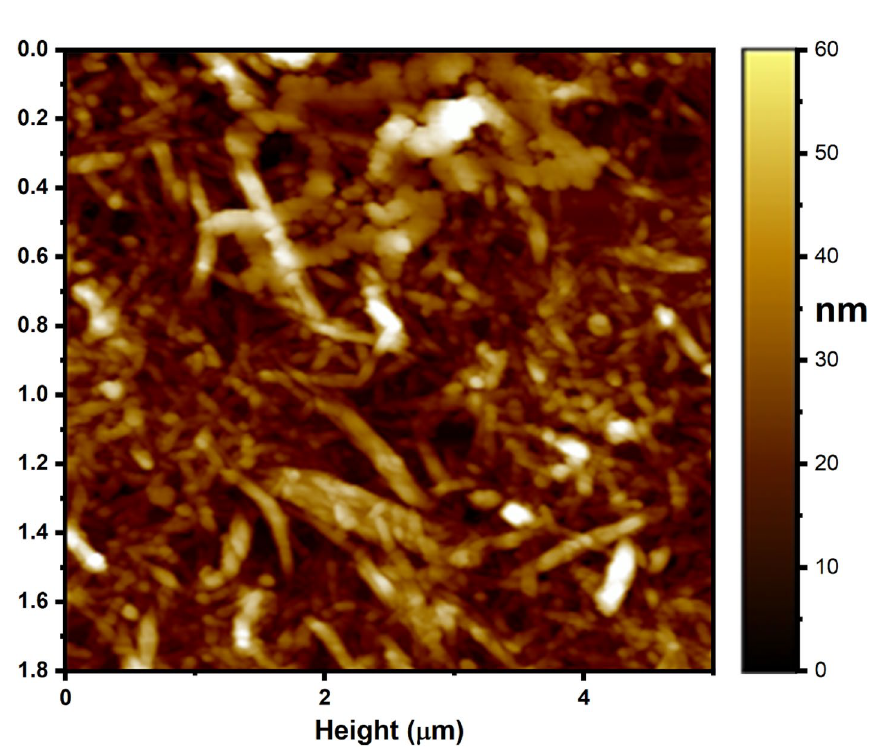
Figure 4. AFM analysis of Ag.